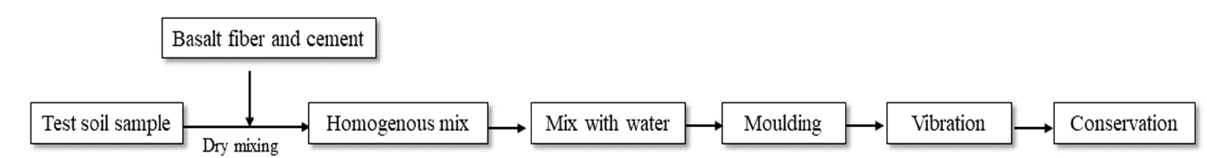
Figure 5. Specimen preparation flowchart.